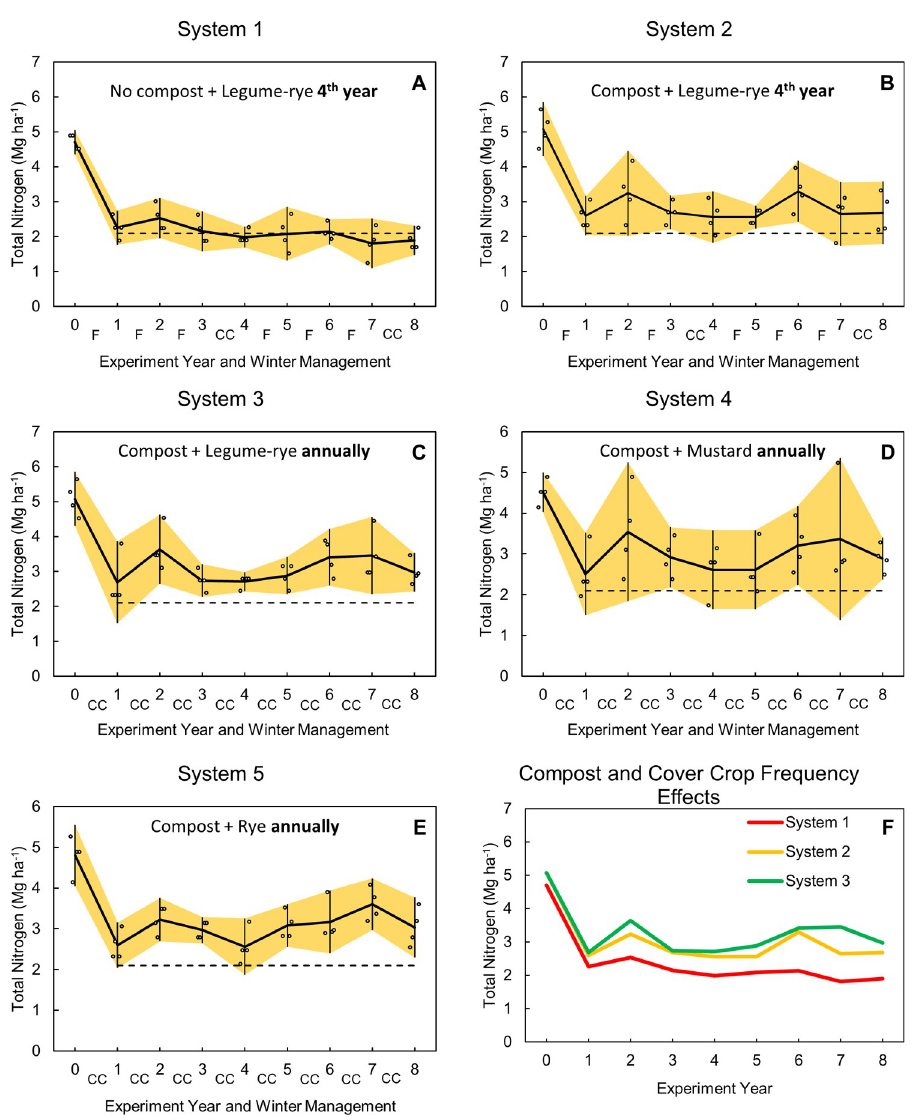
Fig 1. Soil total nitrogen stocks at the 0 to 30 cm depth by system and year. Systems differed by annual compost additions, cover crop type and frequency. The horizontal dashed line at 2.1 Mg ha -1 is the mean soil total nitrogen between years 1 and 8 for System 1 and is included on each graph as a reference. Error bars are 95% confidence intervals (CI) that are connected from year to year by the yellow band. Individual data points for replicates 1 through 4 of each system are clustered around the mean in order from left to right so as not to obscure the CI. The F and CC labels along the x-axis indicate when the system was fallow (F) or cover cropped (CC). The soil was sampled in the fall each year right before the winter cover cropping or fallow period (beginning at time 0); therefore, the 4 th and 8 th sampling dates for Systems 1 and 2 occurred right before they received their first and second cover